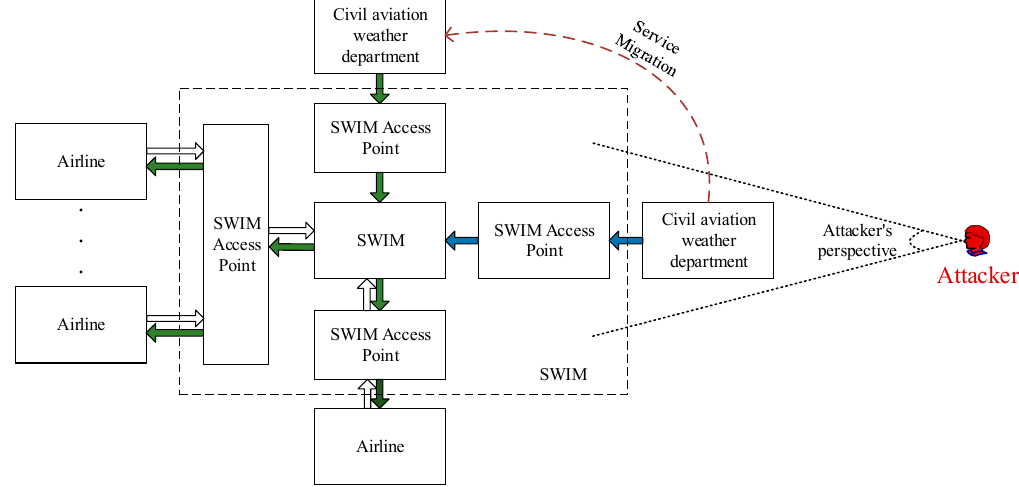
Figure 3. SWIM security threat scenario.